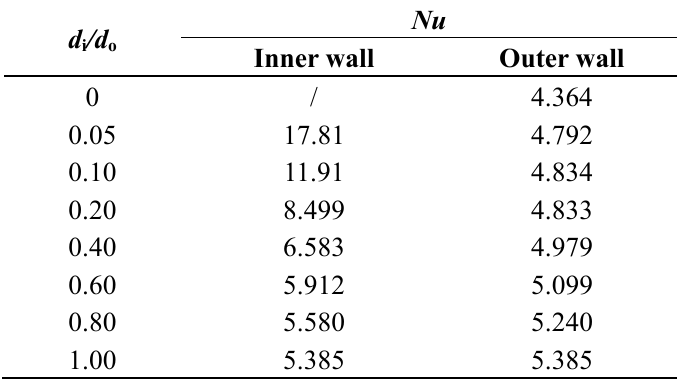
Table 2. Nusselt number of laminar flow in annular